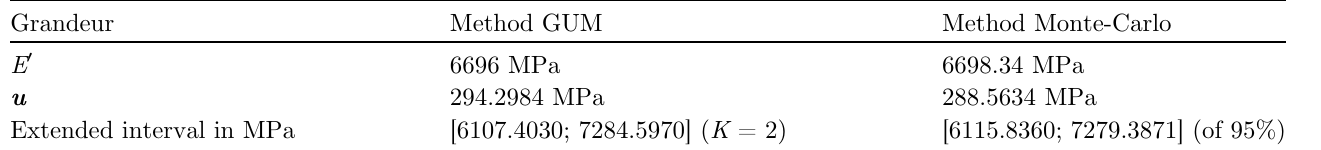
Table 5. Comparison